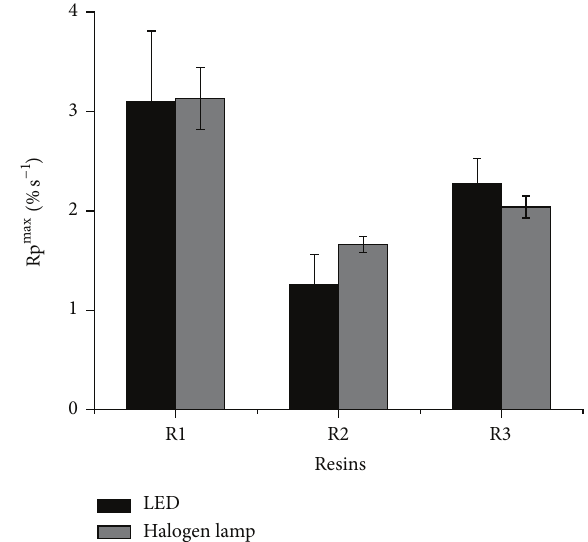
Figure 3: Graph of the mean and standard deviation for Rp max for the three resins (R1, R2, and R3) photoactivated by two light sources (LED and halogen lamp).